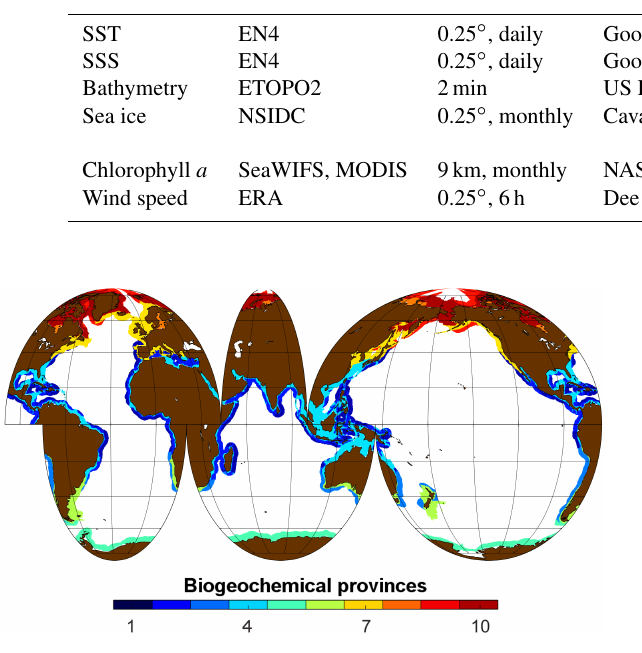
Figure 3. Map of the 10 different biogeochemical provinces gener- ated by the artificial neural network method